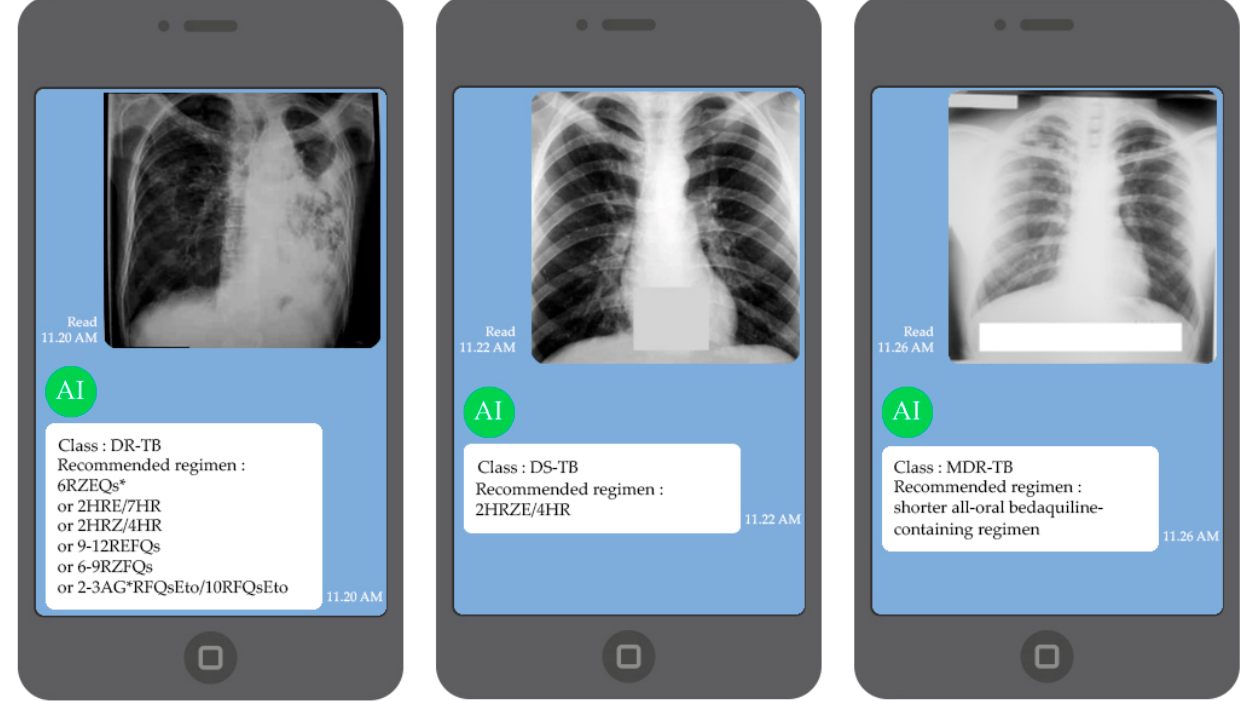
Figure 15. Q and A results of DBOQS.